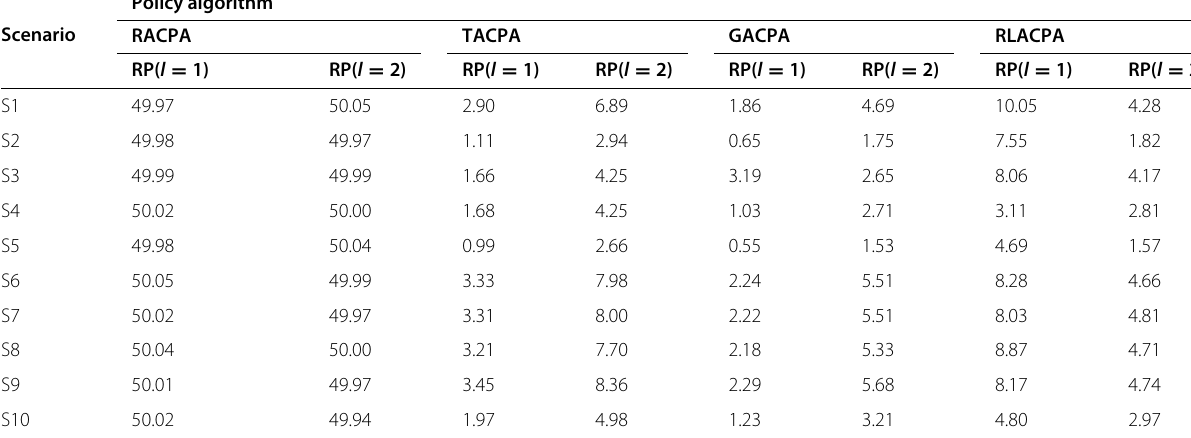
Table 5 RPs (%) in different scenarios